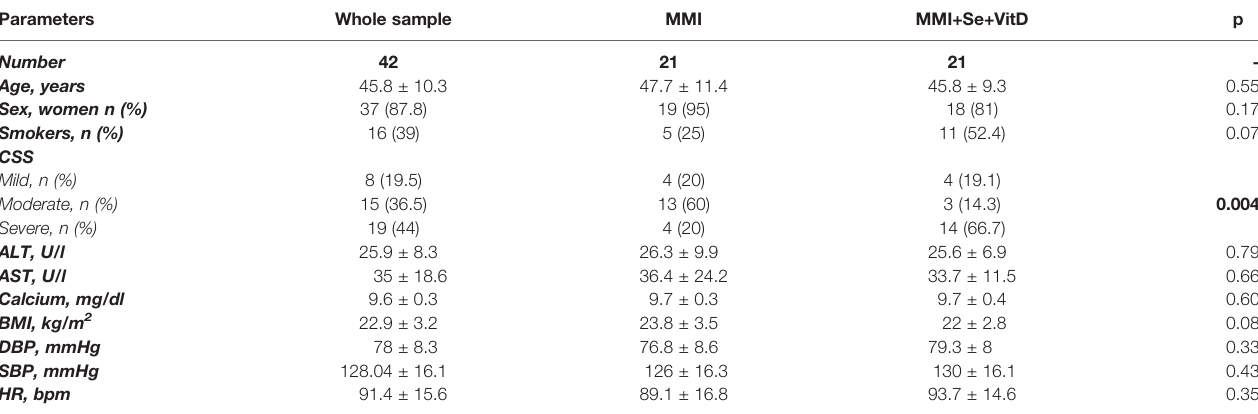
TABLE 1 | Main demographic and clinical features of the 42 Graves ’ disease patients enrolled, in the whole group and divided by arms of treatment. Parameters Whole sample